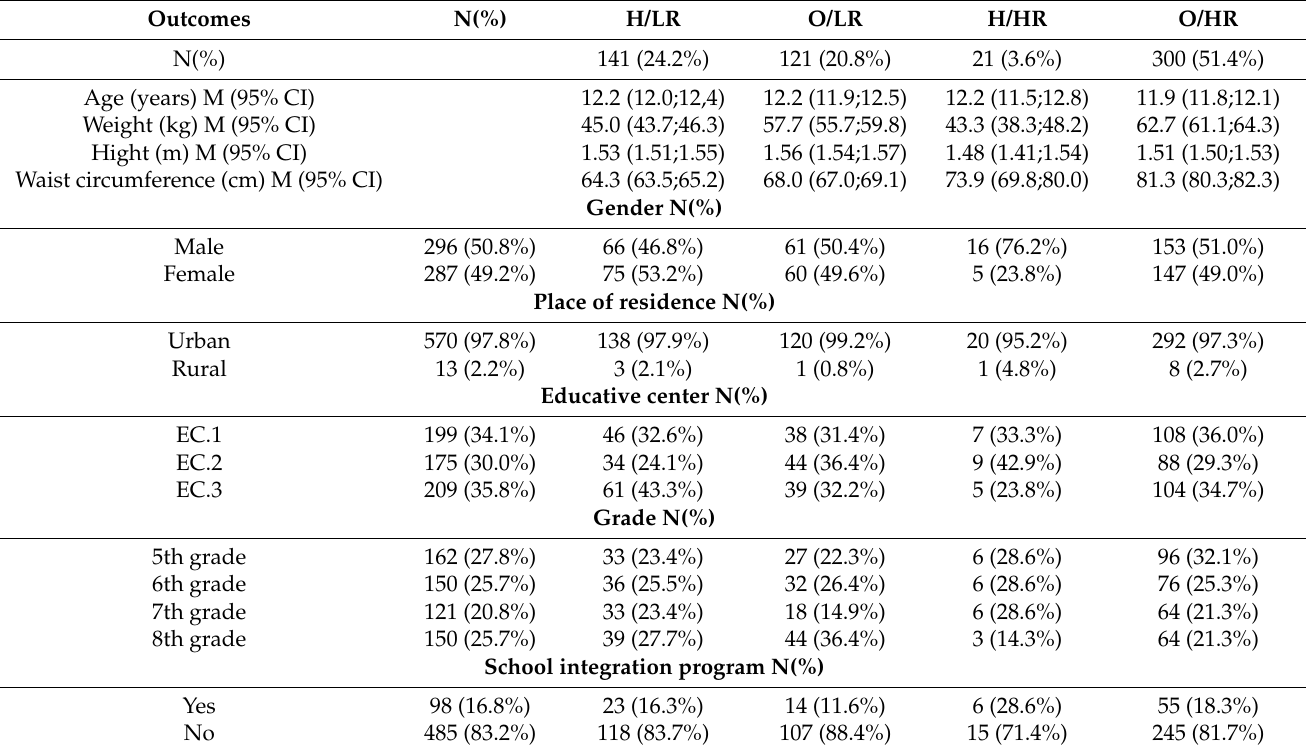
Table 1. Socio-educational characteristics of the schoolchildren according to obesity